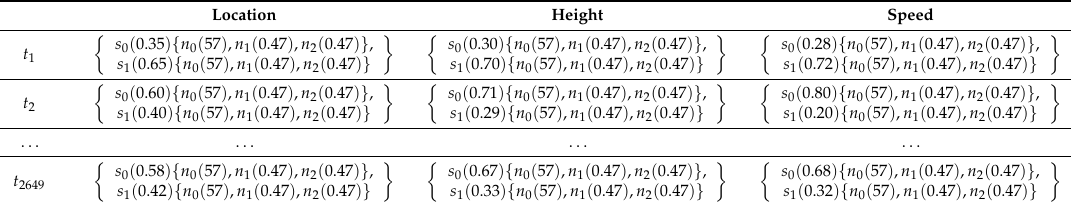
Table 9. Part of the final group evaluation matrix.